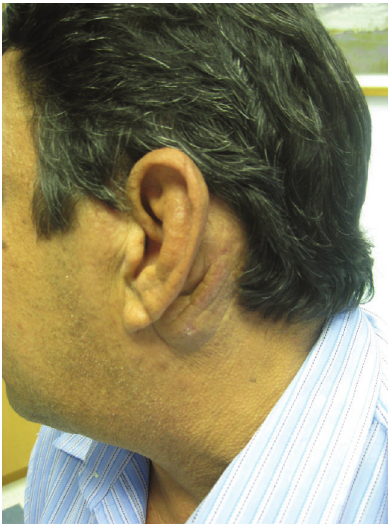
Figure 2: Clinical appearance.